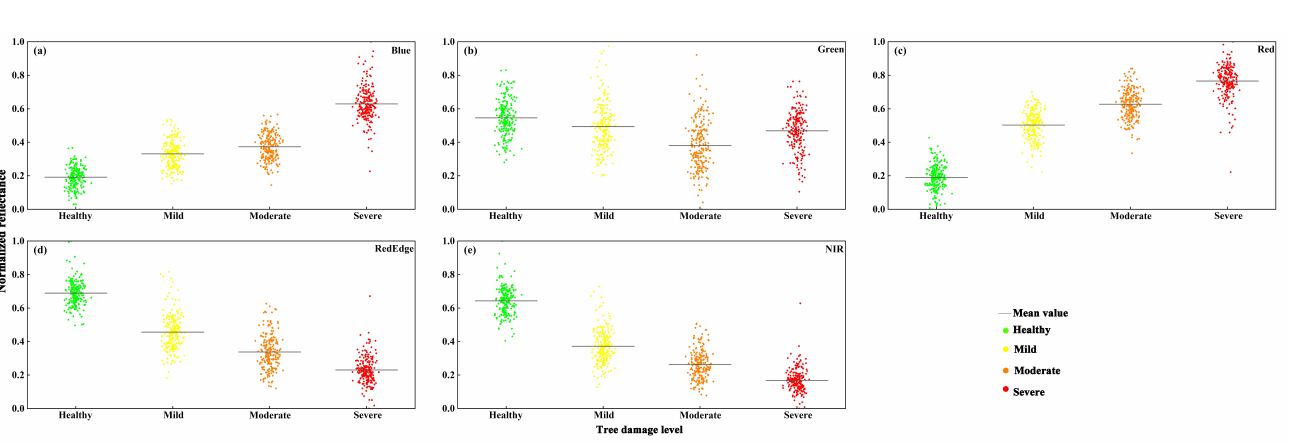
Figure 3. UAV multispectral spectral reflectance of the forest canopy with different degrees of damage: ( a ) Blue band; ( b ) Green band; ( c ) Red band; ( d ) RedEdge band; ( e ) Near Infrared band (NIR).